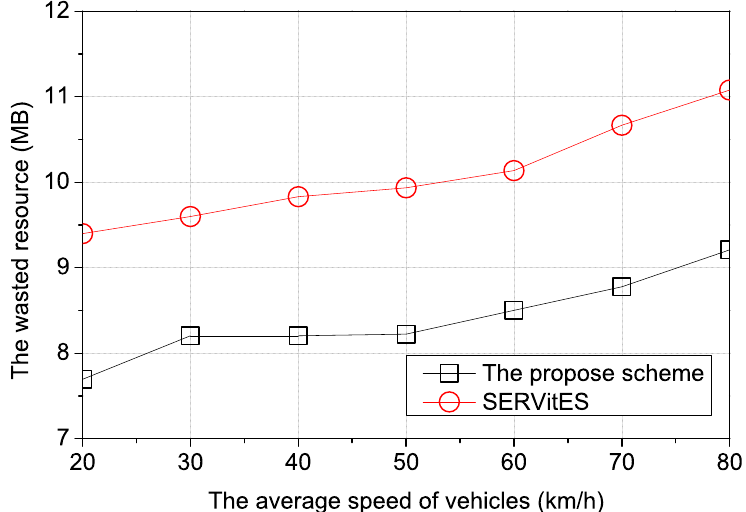
Figure 6. The wasted resources according to the average speed of vehicles.